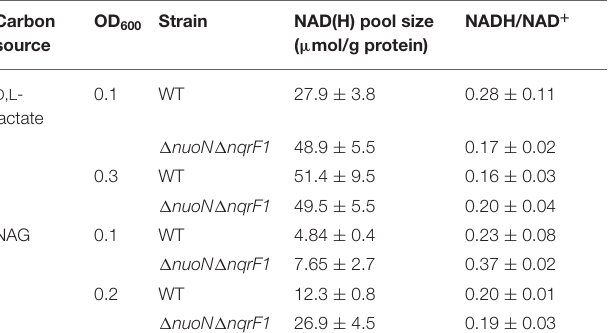
TABLE 2 | Comparison of NAD(H) pools and NADH/NAD + ratios of WT and 1 nuoN 1 nqrF1 when grown in 50mL cultures of M5 supplemented with 0.1% tryptone and either 20mM D,L -lactate or 10mM NAG.